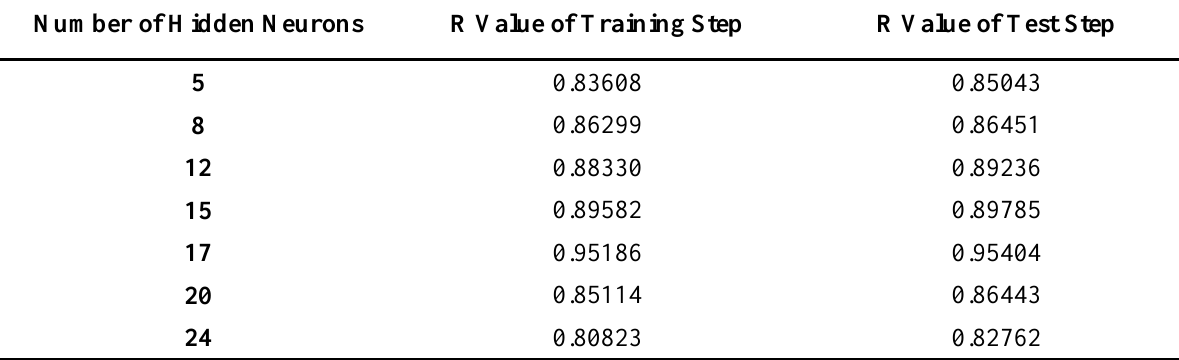
R Values of Training and Test Steps for Various Number of Hidden Neurons. Number of Hidden